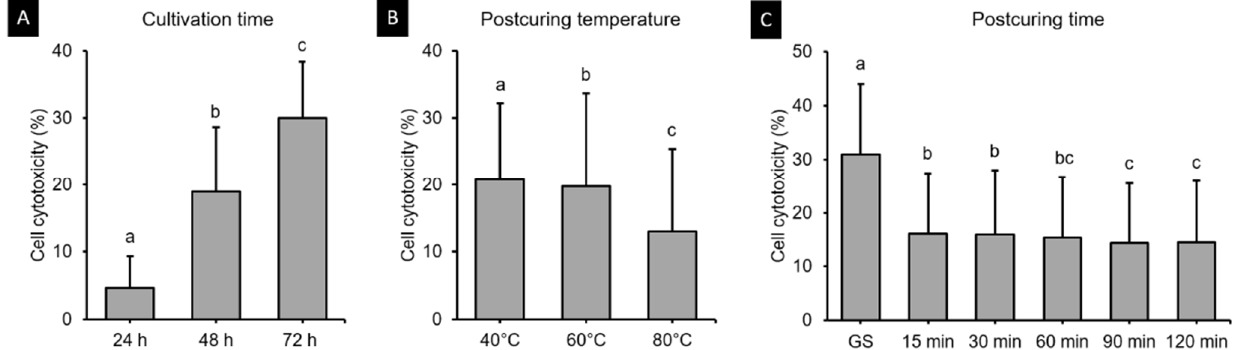
Figure 12. Results from three-way ANOVA. Cell cytotoxicity according to ( A ) cultivation time, ( B ) postcuring temperature, and ( C ) postcuring time. Mean and standard-deviation values are shown. Different lowercase letters indicate a significant difference.